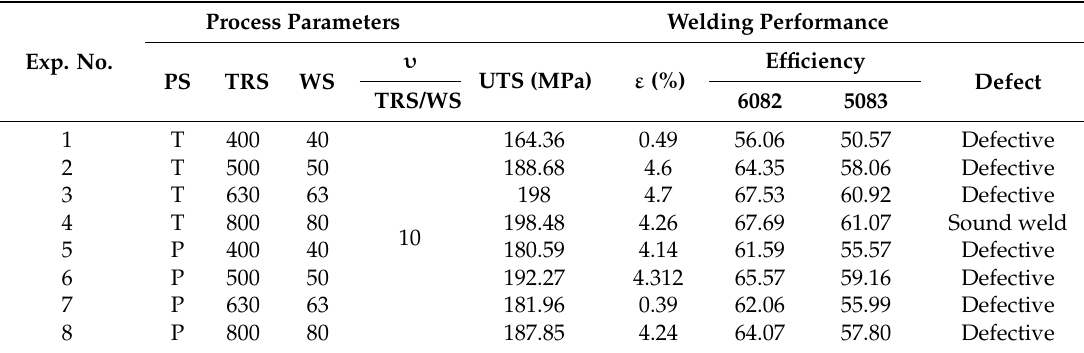
Table 4. FSW experimental layout with responses (UTS, ε ,